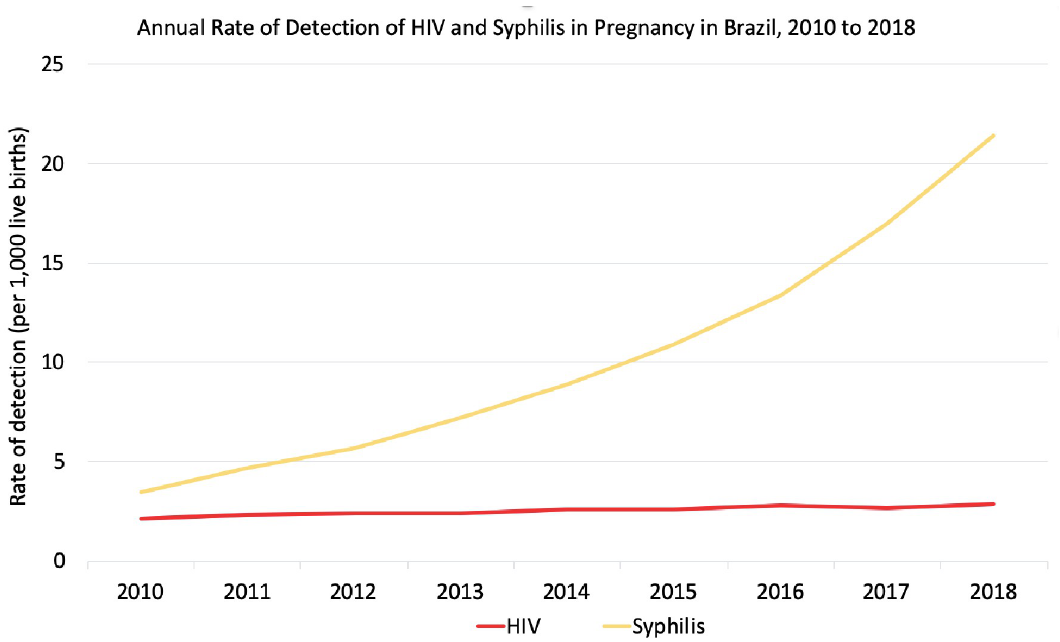
Fig 1. Annual rate of detection of HIV and syphilis in pregnancy in Brazil, 2010 to 2018 (Modified from the Brazilian Ministry of